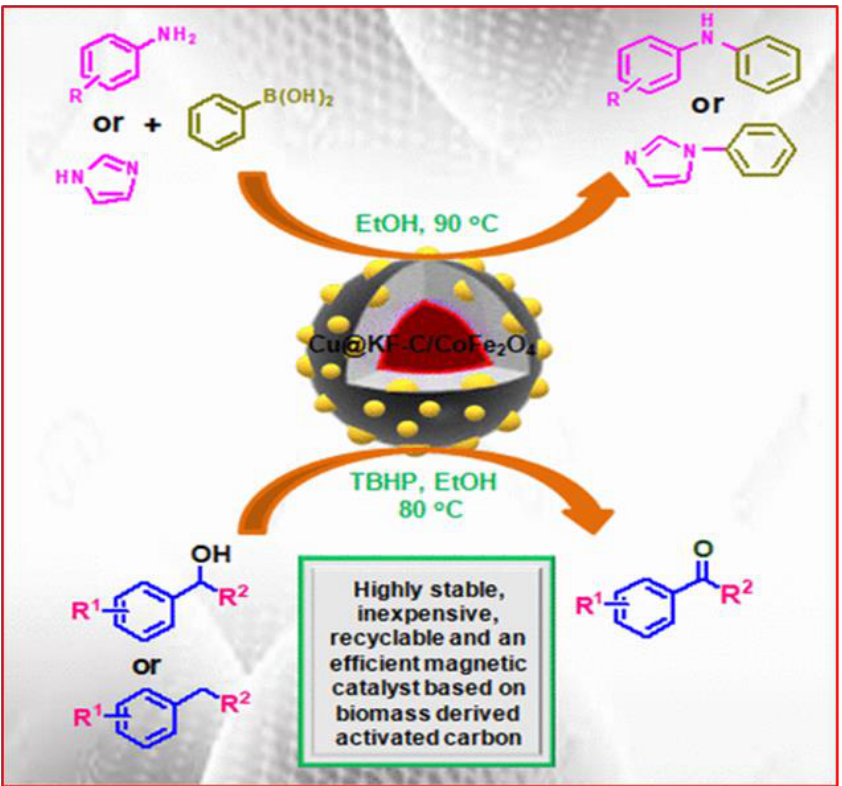
Figure 3. Magnetic catalyst based on biomass-derived activated carbon. Adapted with permission from ref. [20].